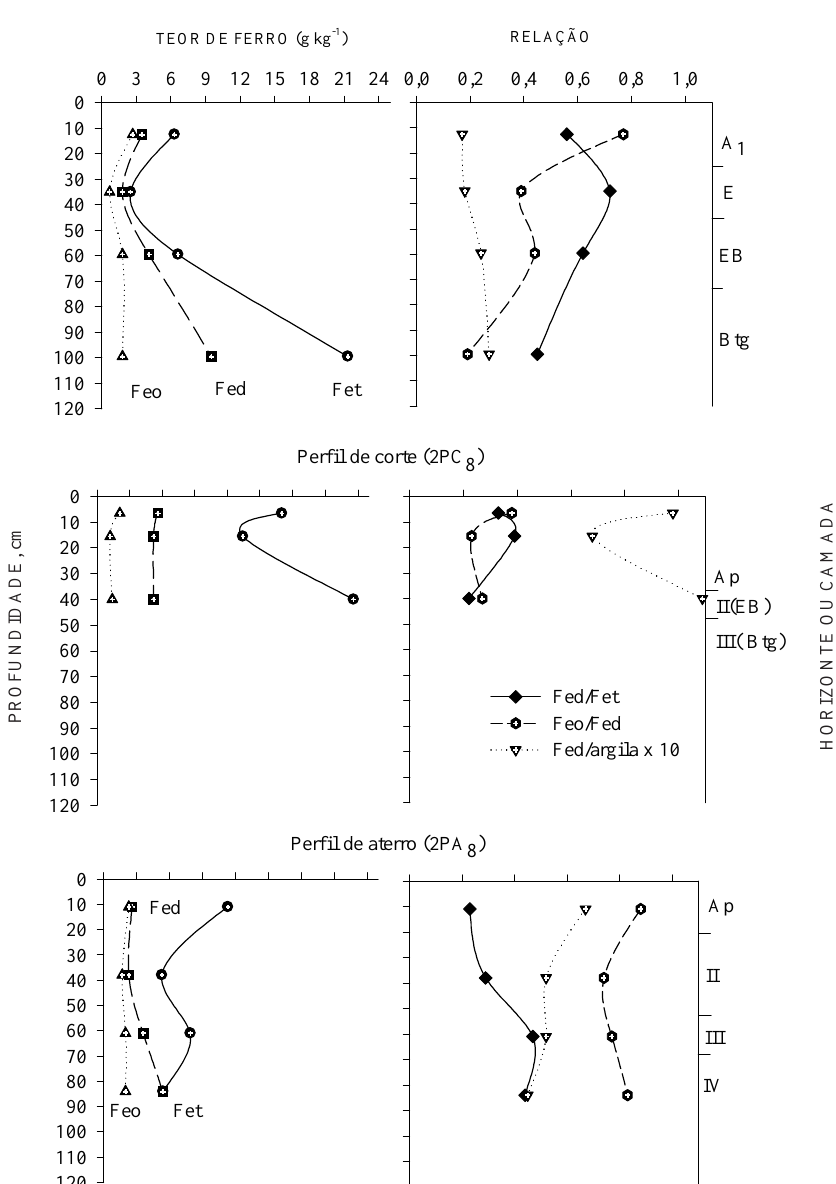
Figura 2. Distribuição dos teores de Fe oxalato (Feo), Fe ditionito (Fed), Fe total (Fet) e as relações Feo/Fed, Fed/Fet e Fed/argila para os perfis: original, de corte e de aterro na área sistematizada há oito anos para cultivo de